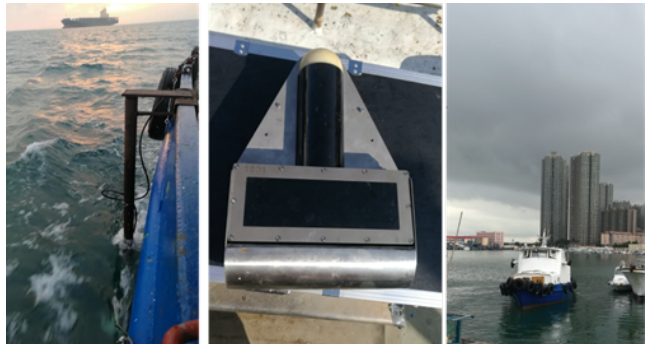
Figure 10. At-sea experiment in Qingdao, China.